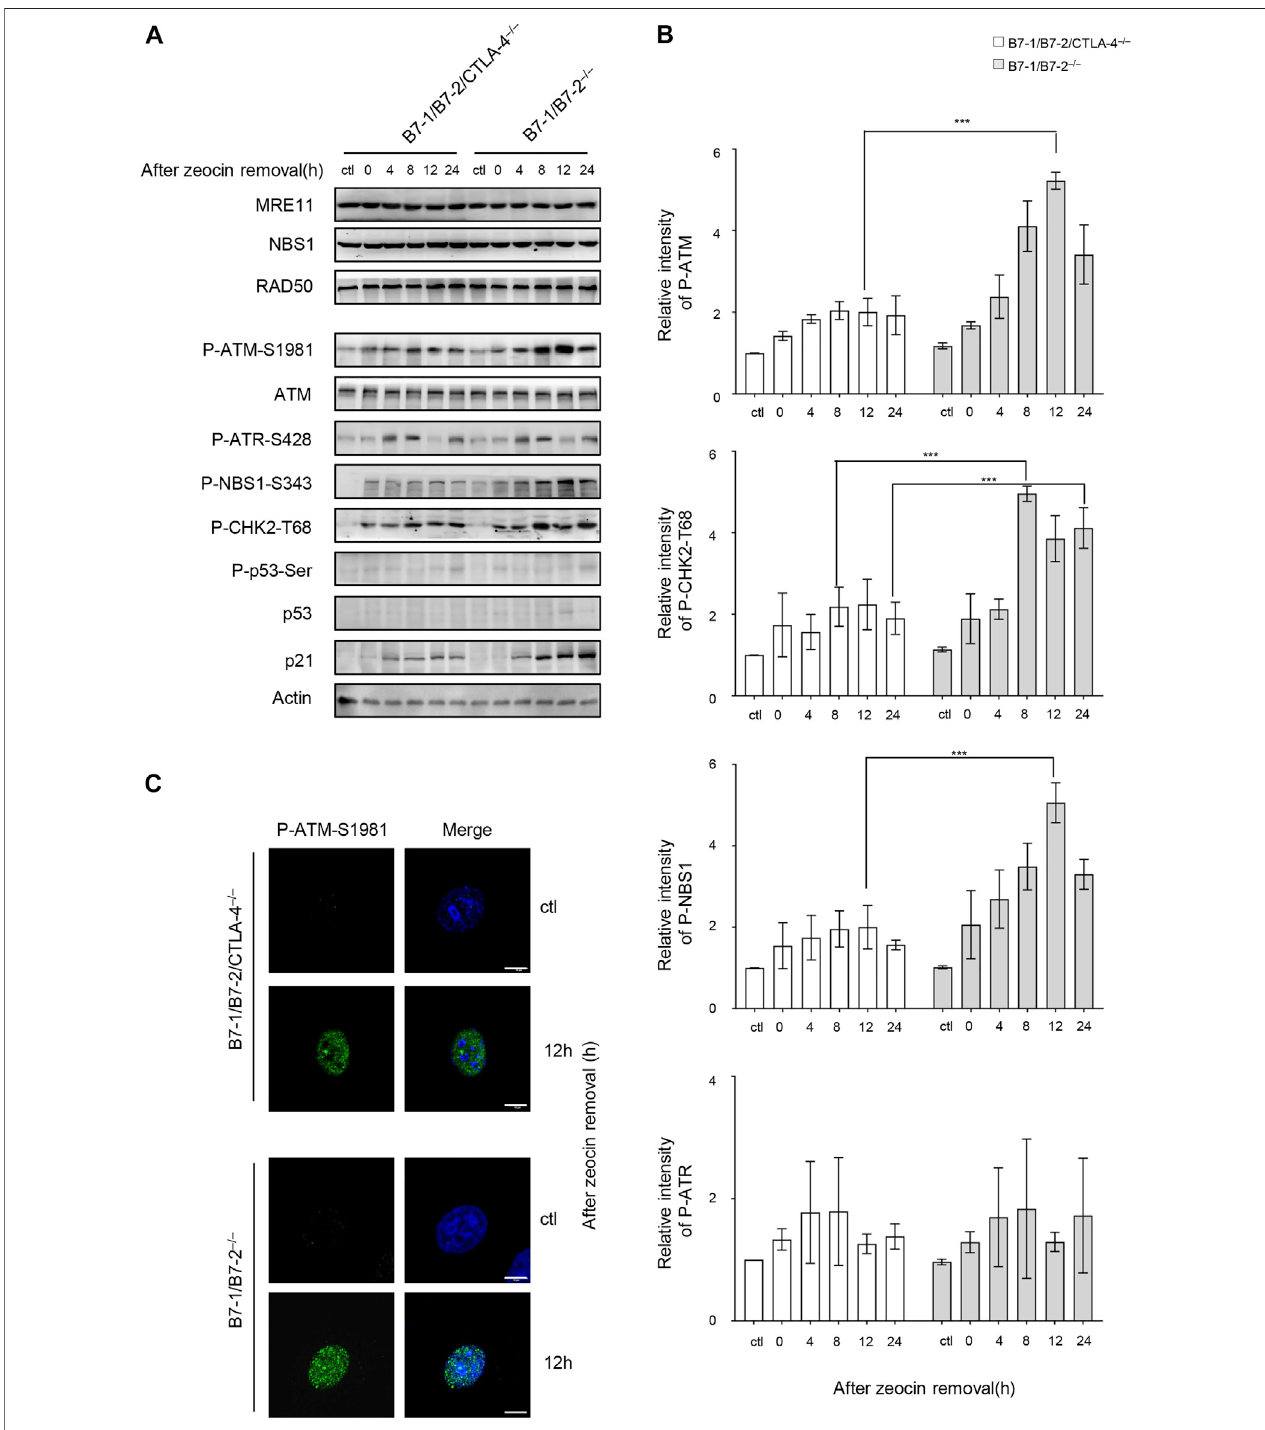
FIGURE4| CTLA-4causesgreaterzeocin-inducedactivationofATMandATM-dependentsignalingpathways.TheCD4 + TcellsfromB7-1/B7-2 − / − andB7-1/B7- 2/CTLA-4 − / − mice were treated with 500 μ g/ml zeocin for 1 h and then harvested at the indicated times. (A) Representative western blotting analyses are shown. The cells were lysed and analyzed at the indicated time intervals. The bar chart represents the intensity of the immunoblot bands in the corresponding group. (B) Quanti fi cation of P-ATM and P-CHK2-T68 immunoblots in the corresponding groups. Each experiment was independently performed three times ( n = 3). (C) P-ATM-S1981 was detected using immuno fl uorescence staining. The cells were subjected to immuno fl uorescence staining using speci fi c antibodies against P-ATM- S1981 (green) and nuclei (DAPI, blue). Scale bar, 10 μ m.